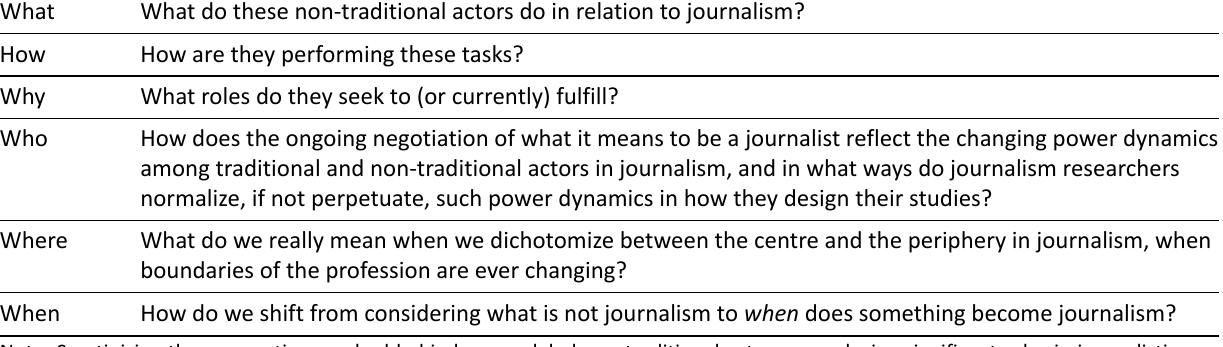
Table 1. Components of key